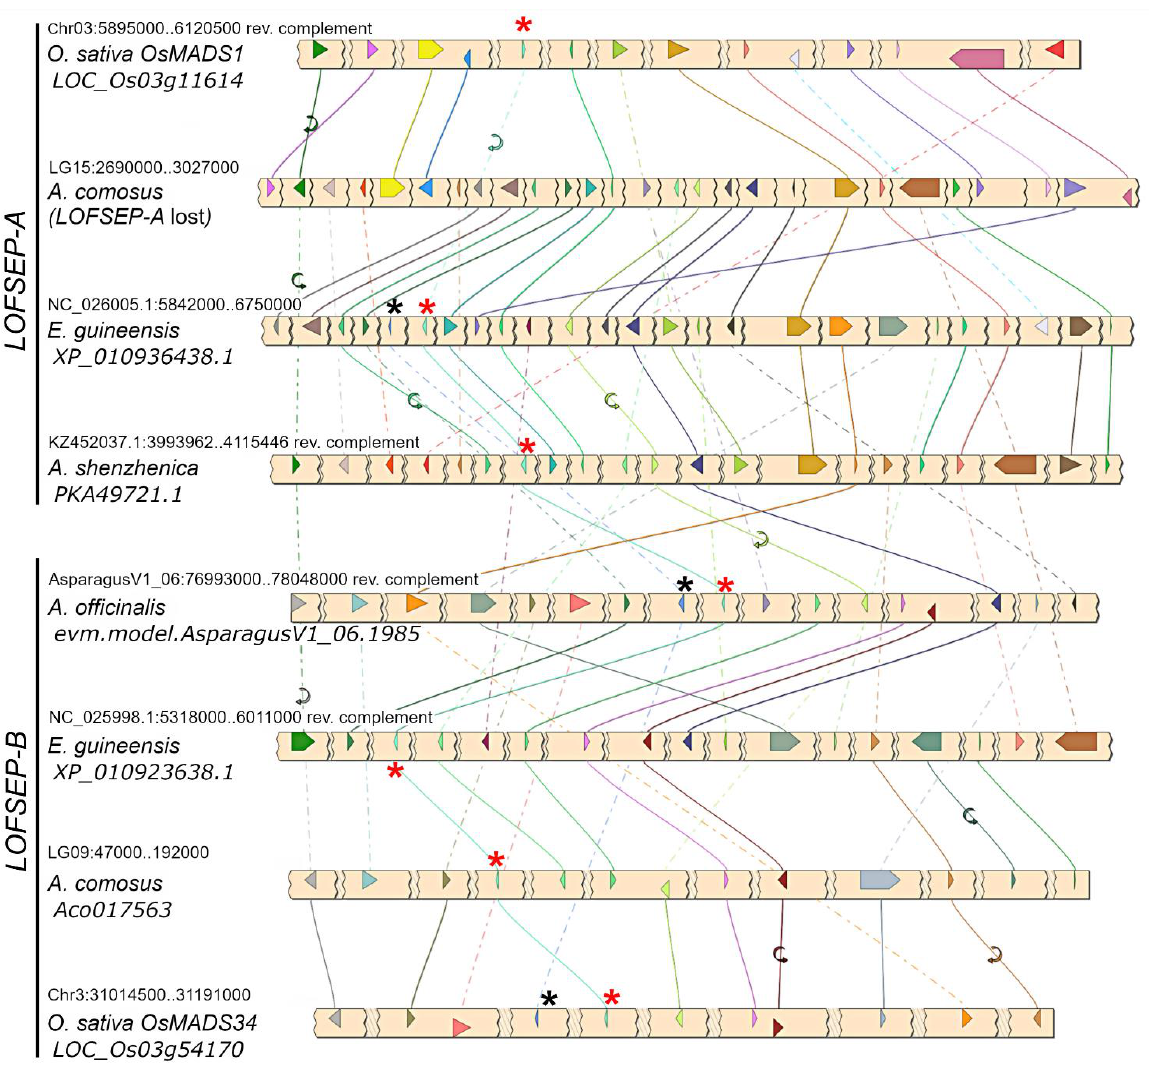
Figure 1. ML phylogenetic analysis of the SEPALLATA ( SEP ) subfamily genes from the core mono- cots commelinids and Asparagales. Dichotomies unequivocally linked to the angiosperm WGD- ε and the grass WGD- ρ events are marked with a red star. The three LOFSEP subclades of grasses, OsMADS1 , OsMADS5 and OsMADS34 , are marked with different shades of green. The two SEP3 subclades of grasses, OsMADS7/45 and OsMADS8/24 , are marked with different shades of blue. Two tandem duplication events of SEP3 genes were detected in Asparagus officinalis and in Elaeis guineensis , which are marked with green and blue connected circles, respectively.